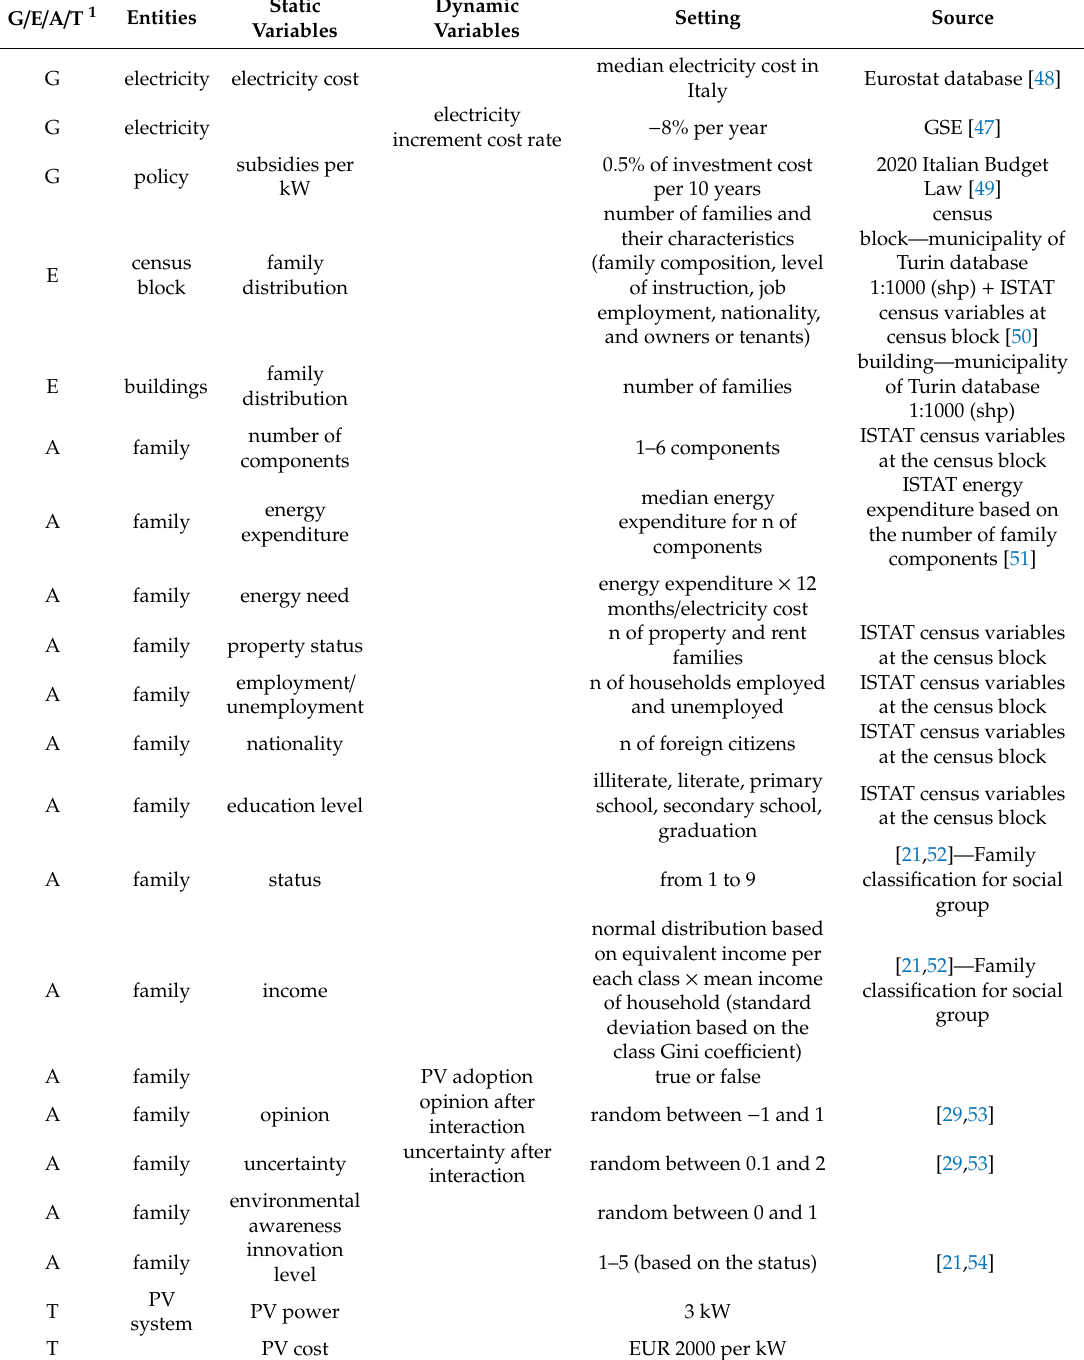
Table 3. Entities, static and dynamic variables in the